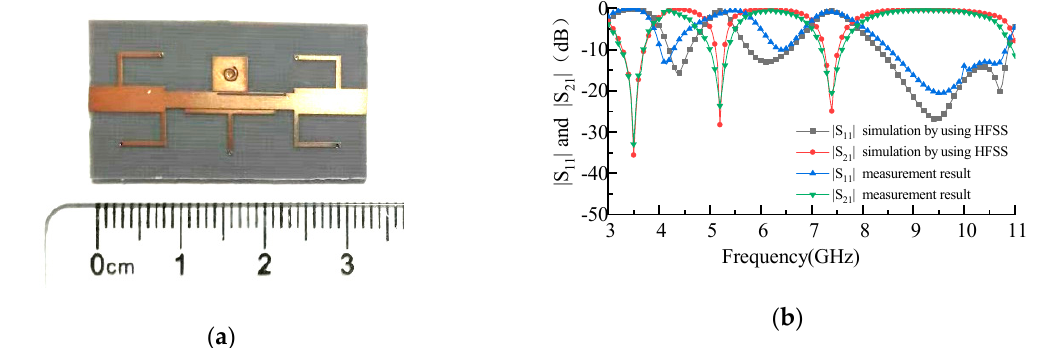
Figure 14. ( a ) The photograph of the fabricated triple notches bandstop microstrip filter using ASEBG; ( b ) the simulation results of the filter by using HFSS .